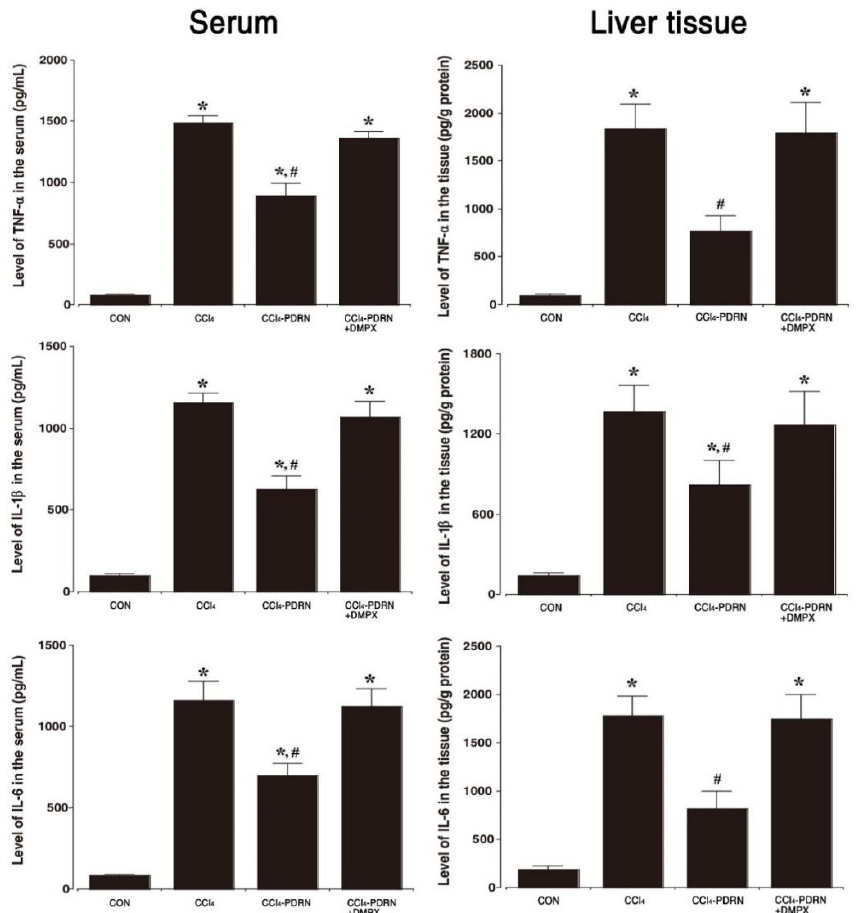
e ffi cacy, the inhibitory e ff ect of PDRN on the production of pro-inflammation cytokines disappeared after co-treatment of DMPX with PDRN. Int. J. Mol. Sci. 2020 , 21 , x FOR PEER REVIEW